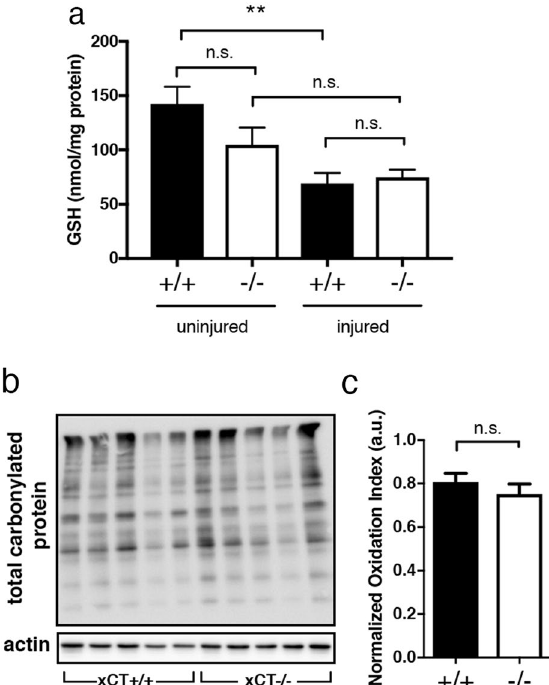
Figure 3. Glutathione levels and oxidative stress-related markers following SCI. Spinal GSH content in pre- injury and injury groups. Injured xCT+/+ and xCT−/− mice had equal amount of GSH two weeks after SCI ( a ). GSH levels are significantly decreased after injury in xCT+/+ mice. ** p < .01, two-way ANOVA followed by Sidak multiple comparisons test, n = 5–7 mice/group. Protein oxidation detection kit was used to quantify the amount of carbonylated proteins in the spinal cord at 2 weeks post-injury in injured xCT+/+ and xCT−/− mice ( b ). When normalized to actin, the oxidation index (a.u.) did not show any significant difference between groups ( c ). Mann–Whitney test, n = 5 mice/group. Data are expressed as mean +/−